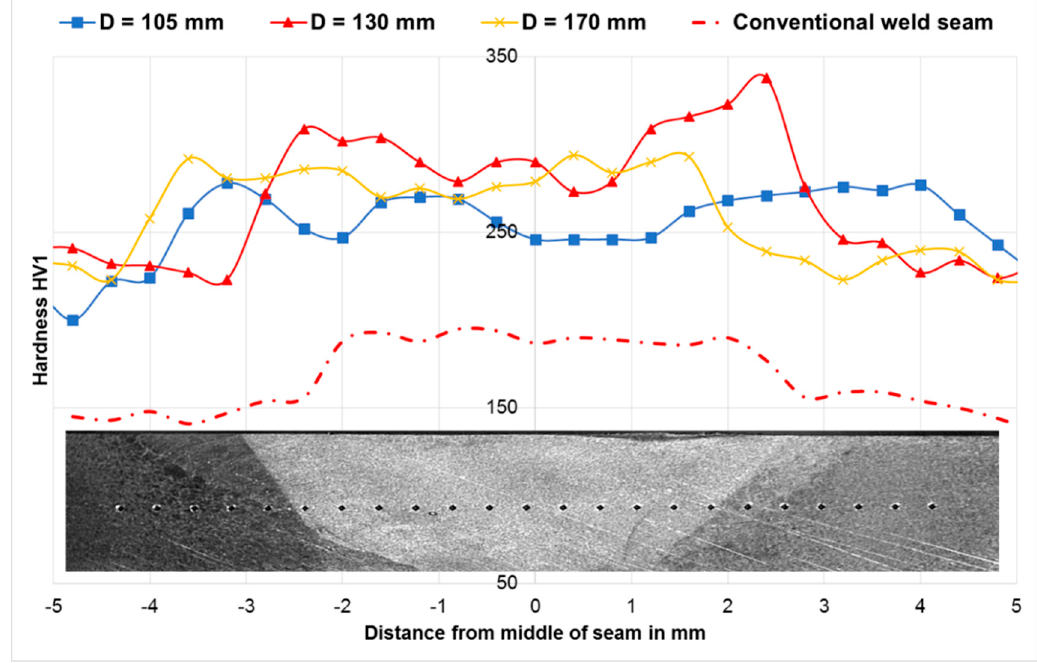
Figure 9. Hardness measurements of the weld metal and HAZ for different torch to roller distances.